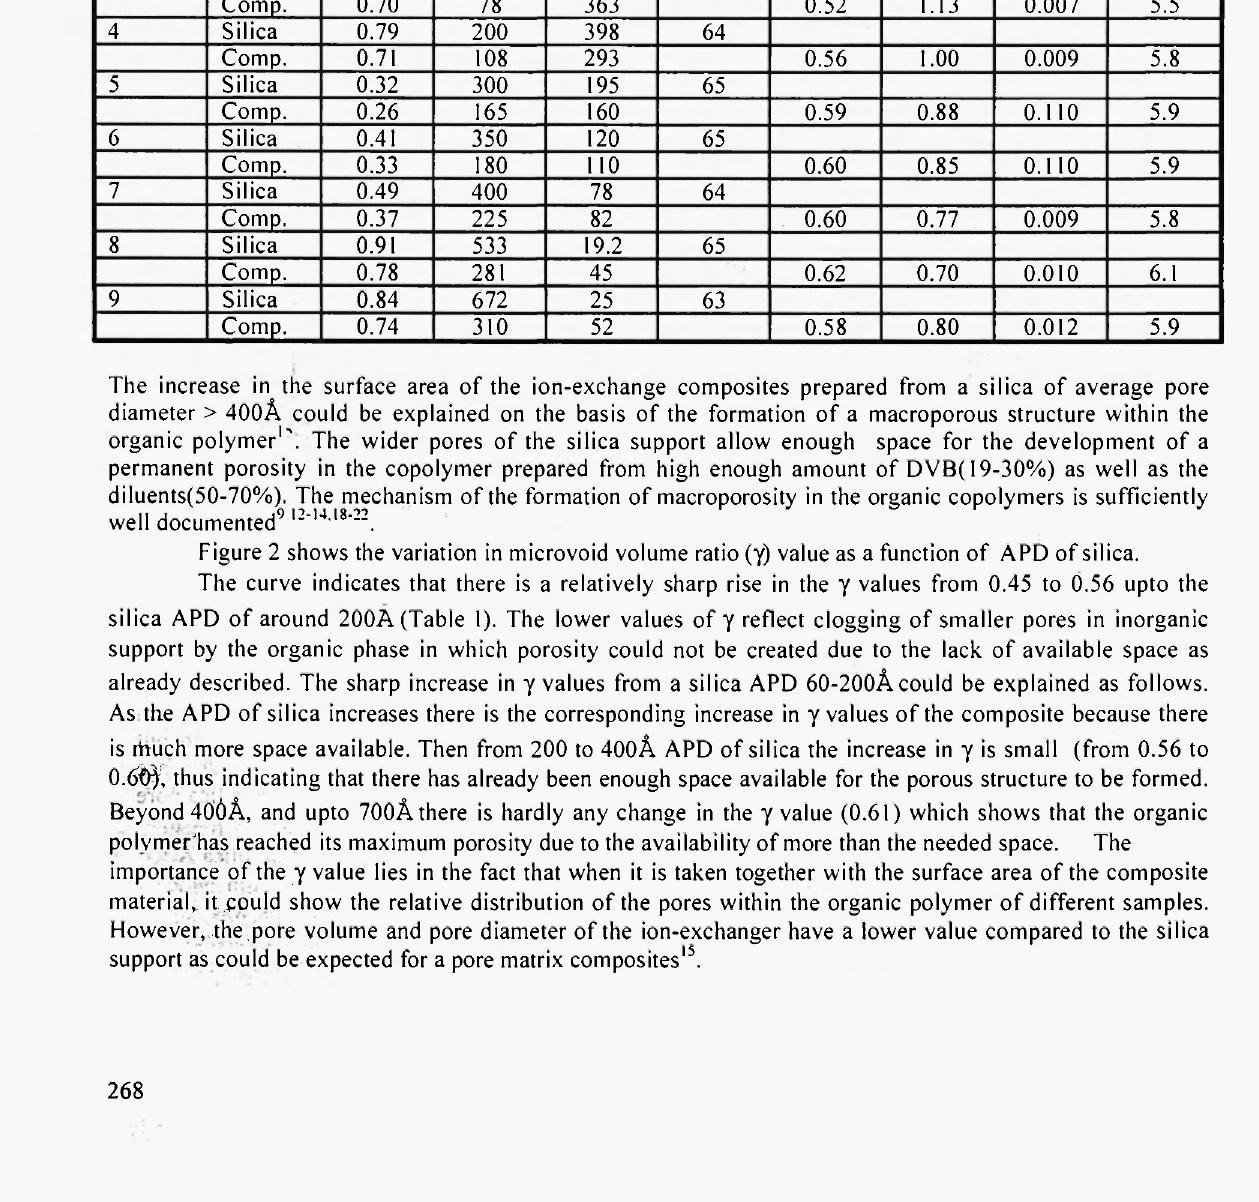
Table I Pore volume (Vp). average pore diameter (APD), surface area (S], porosity (a), microvoid volume ratio